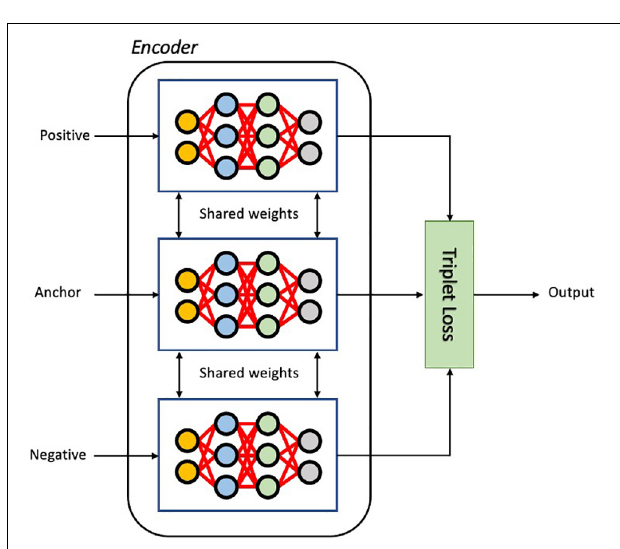
FIGURE 3 | The architecture of the Siamese network with triplet loss function during training. As input, a triplet of images (Anchor, Positive and Negative) is given to three identical encoder networks. The embedded vectors of three input images are used to calculate the triplet